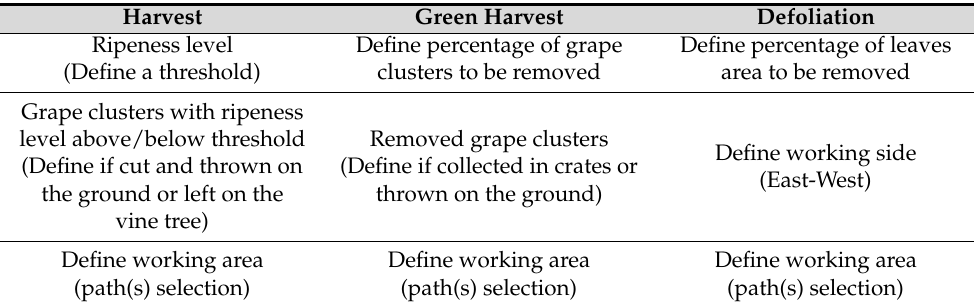
Figure 6. Results of the processing steps regarding defoliation: ( a ) RGB image; ( b ) Leaves detection result; ( c ) Definition of ROI and applied grid. Blue squares refer to the selected set of α squares, red boxes refer to the defoliation set of b squares and white dots inside red squares indicate the CoMs. Result for P = 30%; ( d ) Result for P = 50%. Table 4. Parametrization of agricultural